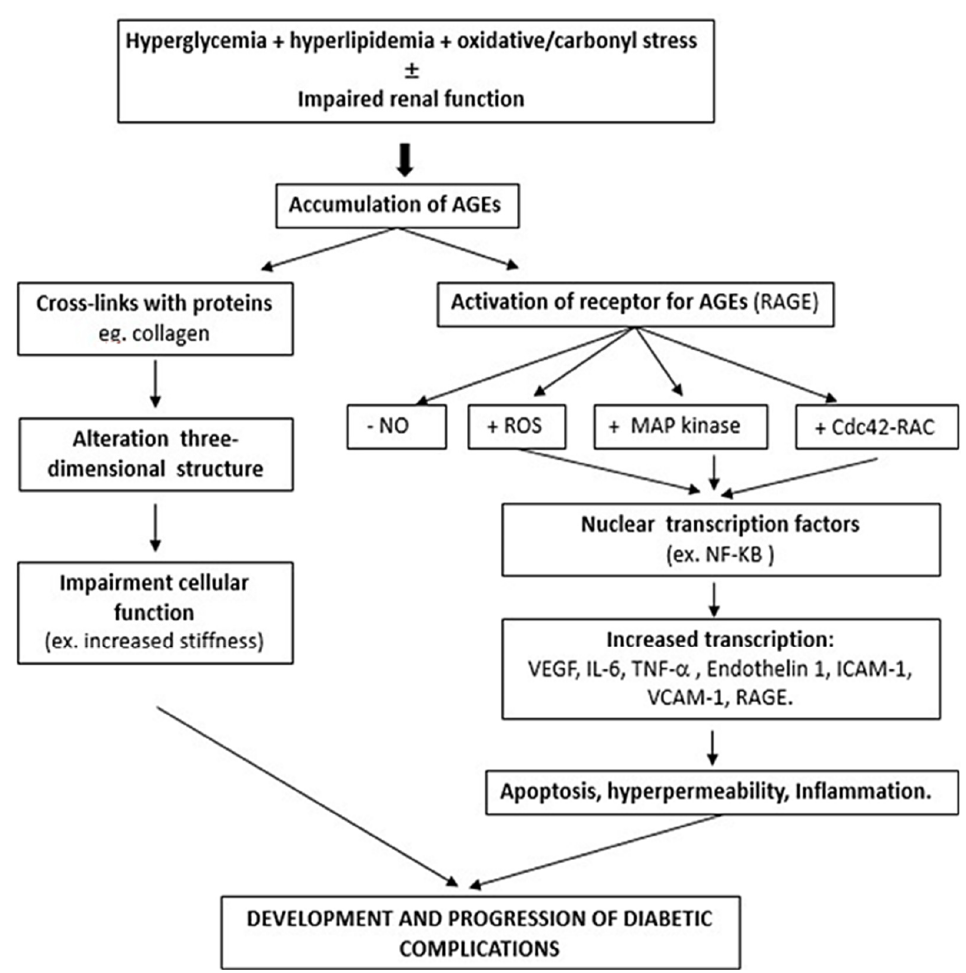
Figure 1. Multi-pathway contribution of AGEs to diabetic complications. Accumulation of advanced glycation end product (AGE) may result from hyperglycemia, hyperlipidemia, and oxidative stress, with or without impaired renal function. AGEs can form cross-links with proteins that affect the three-dimensional structure and thereby the functions of these proteins, and they can also cause deleterious effects by the activation of receptors for AGEs (RAGEs), which in turn can lead to activation of second messengers and transcription factors that up-regulate pro-inflammatory cytokines and mediators of oxidative stress. These effects modify pathways which contribute to the development and progression of diabetic complications. NO, nitric oxide; ROS, reactive oxygen species; MAP, mitogen-activated protein; Cdc42, cell division cycle 42 protein; NF-KB, nuclear factor kappa-light-chain-enhancer of activated B cells; VEGF, vascular endothelial growth factor; TNF- α , tumor necrosis factor α ; ICAM-1, intercellular adhesion molecule-1, VCAM-1 Vascular cell adhesion protein 1.